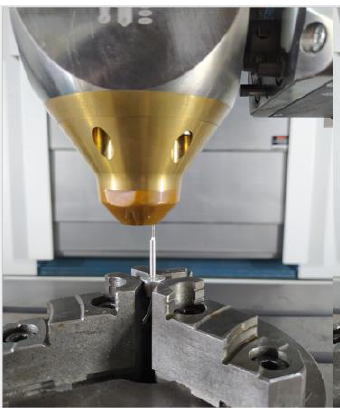
Figure 5: Starting position of pitot tube in Y axes.